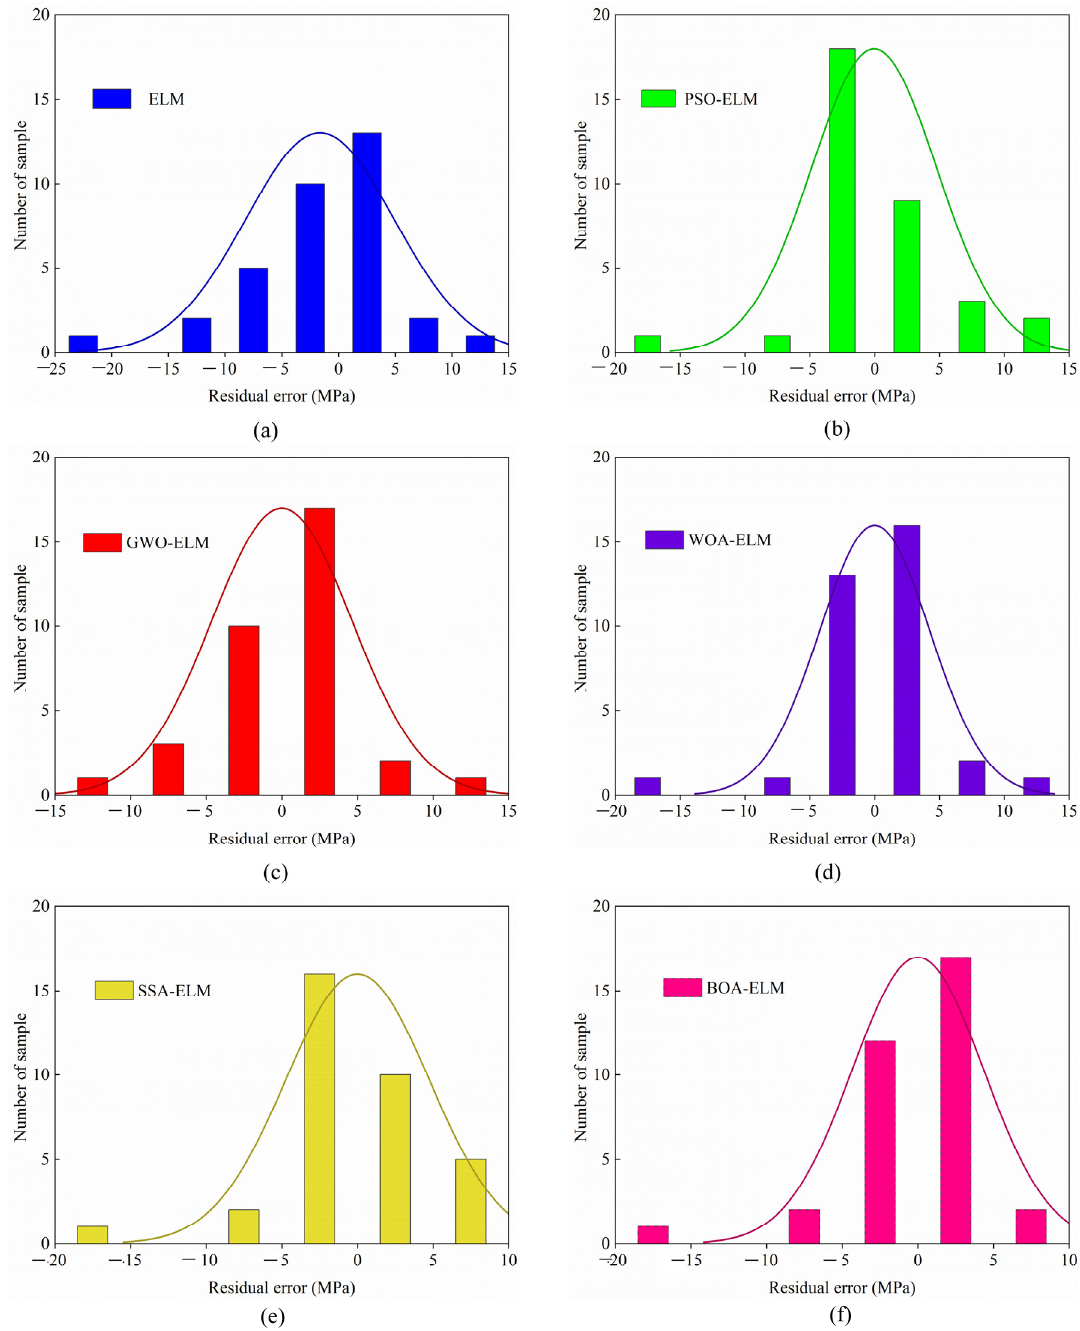
Figure 7. Frequency distributions of residual errors utilizing a single ELM model and hybrid ELM models optimized by PSO, GWO, WOA, BOA, and SSA. (a) residual errors based on ELM model; (b) residual errors based on PSO-ELM model; (c) residual errors based on GWO-ELM model; (d) residual errors based on BOA-ELM model; (e) residual errors based on WOA-ELM model; (f) residual errors based on SSA-ELM model.